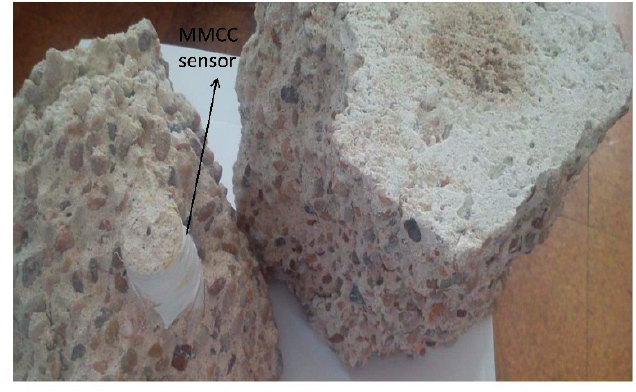
Figure 13. MMCC sensor obtained after the breaking of the cubic concrete